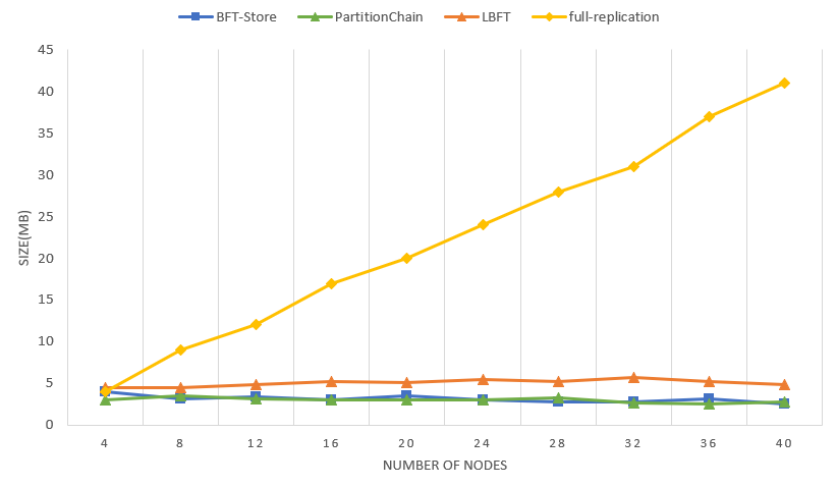
Figure 5. The storage consumption of LBFT, full-replication, PartitionChain, and BFT-Store against the number of